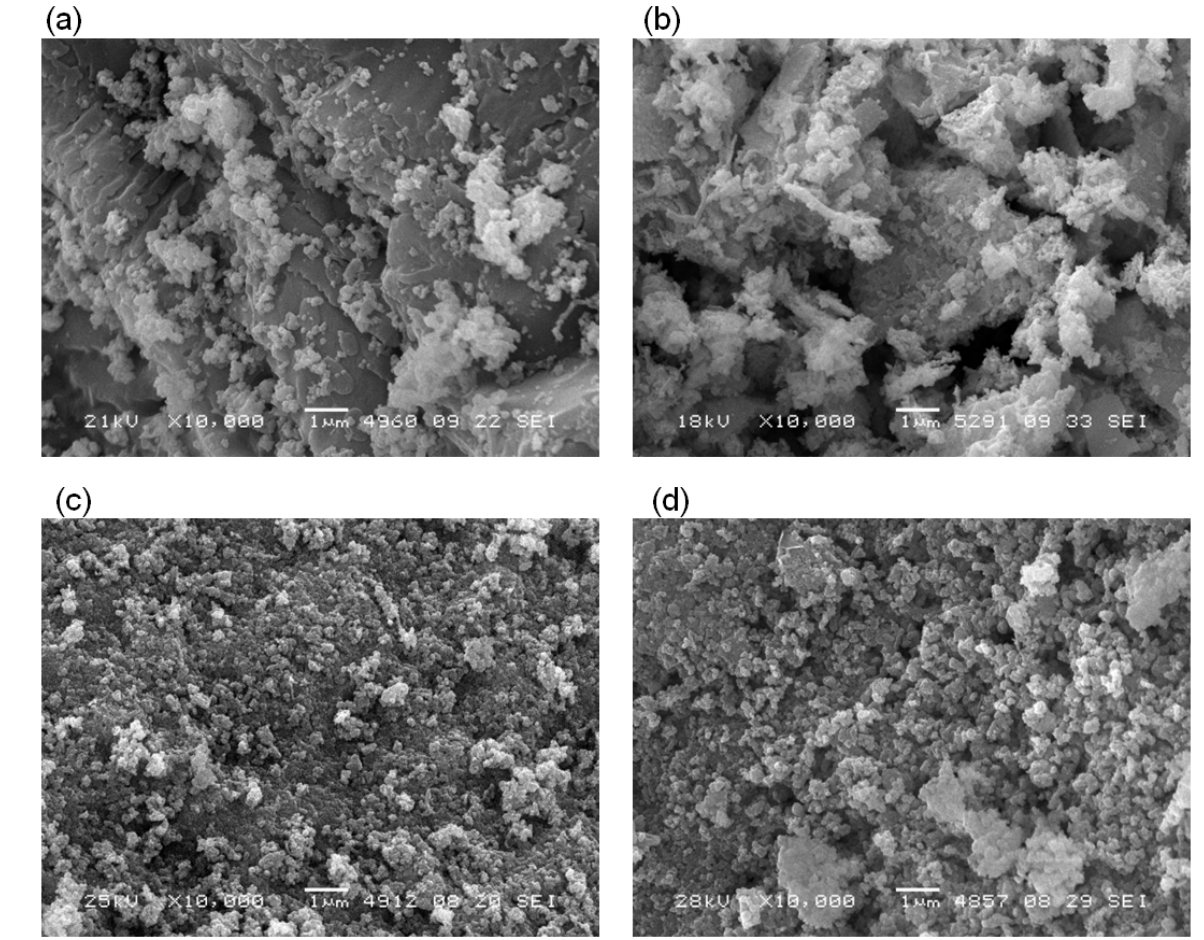
Figure 23. SEM images of spent (CeM) 0.8 Ni 0.2 O y samples: without M ( a ), M = Al ( b ), La ( c ) and Mg ( d ). ( b – d )—M/Ce molar ratio is equal to 1. Reaction conditions: 800 °C, 24 h.